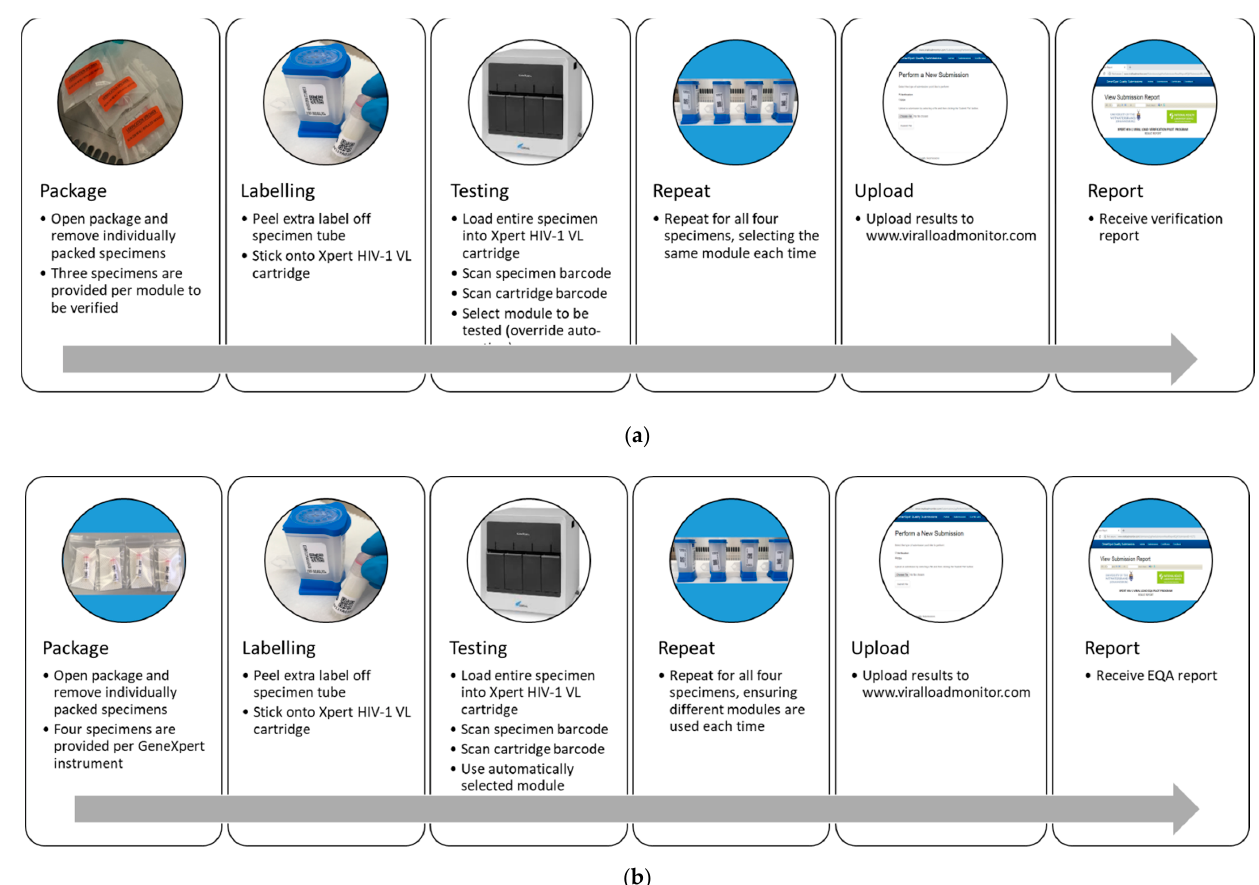
Figure 1. Processing of Verification and EQA panels. ( a ) Verification panel: same module must be used for each set of specimens. Verification panels are labelled with orange labels to remind users of this. ( b ) EQA panel: different modules must be used for each specimen. HIV: human immunodeficiency virus. VL: viral load. cp/mL: copies per milliliter. EQA: external quality assessment.